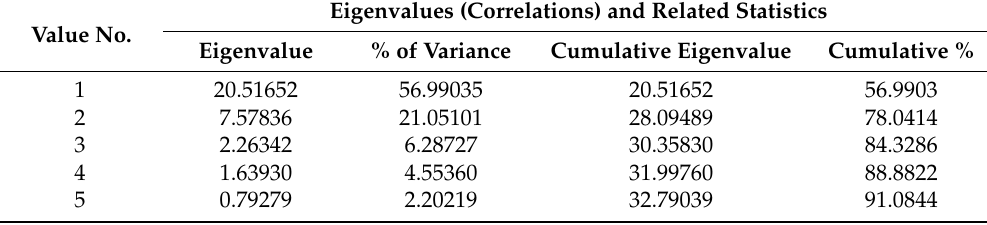
Table 2. Eigenvalues of new